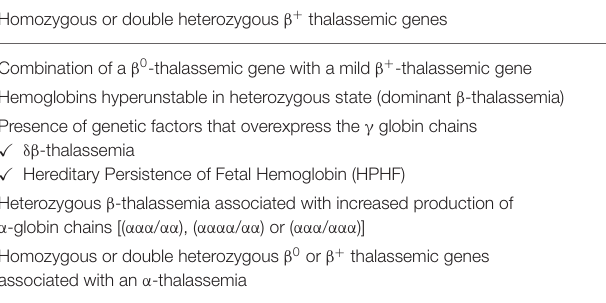
TABLE 1 | Molecular basis of β -thalassemia